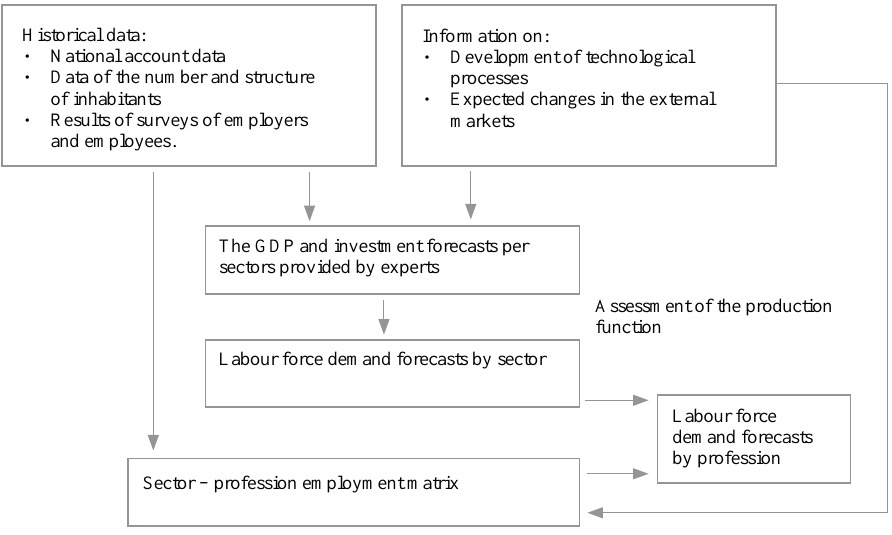
Fig. 3. Scheme of the labour force demand forecasting